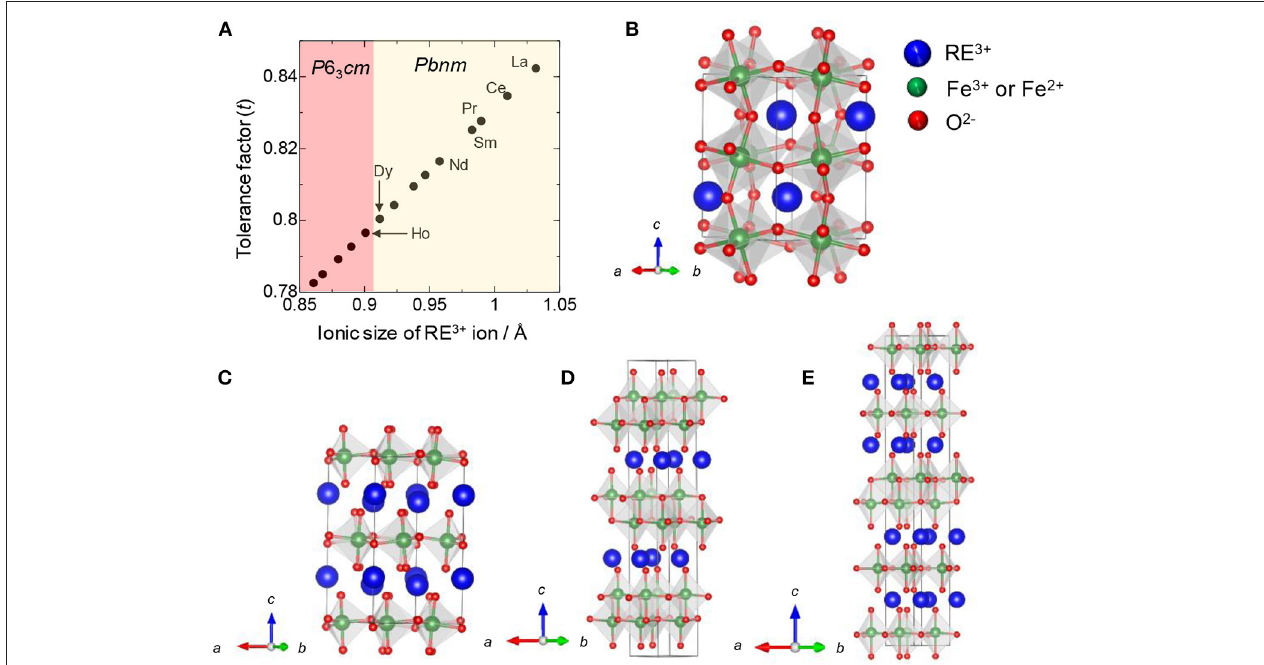
FIGURE 1 | (A) Tolerance factor and stable crystal structure against ionic size of RE in REMnO 3 , (B) Orthorhombic REFeO 3 ( o -REFeO 3 ) or o -REMnO 3 with the space group of Pbnm , (C) Hexagonal REFeO 3 ( h -REFeO 3 ) or h -REMnO 3 with the space group of P 6 3 cm , (D) REFe 2 O 4 , and (E) RE 2 Fe 3 O 7